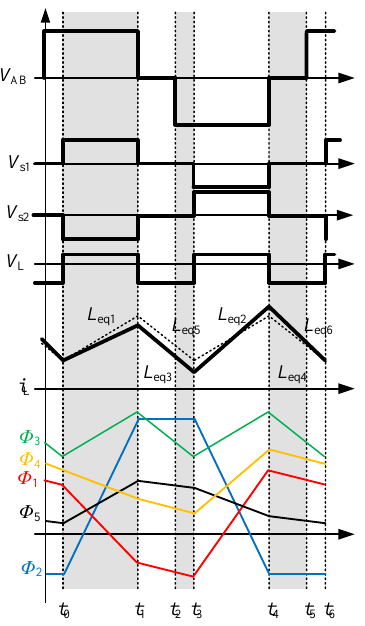
Figure 6. Voltage waveform, current waveform, and magnetic flux waveform of each magnetic path during a duty cycle.